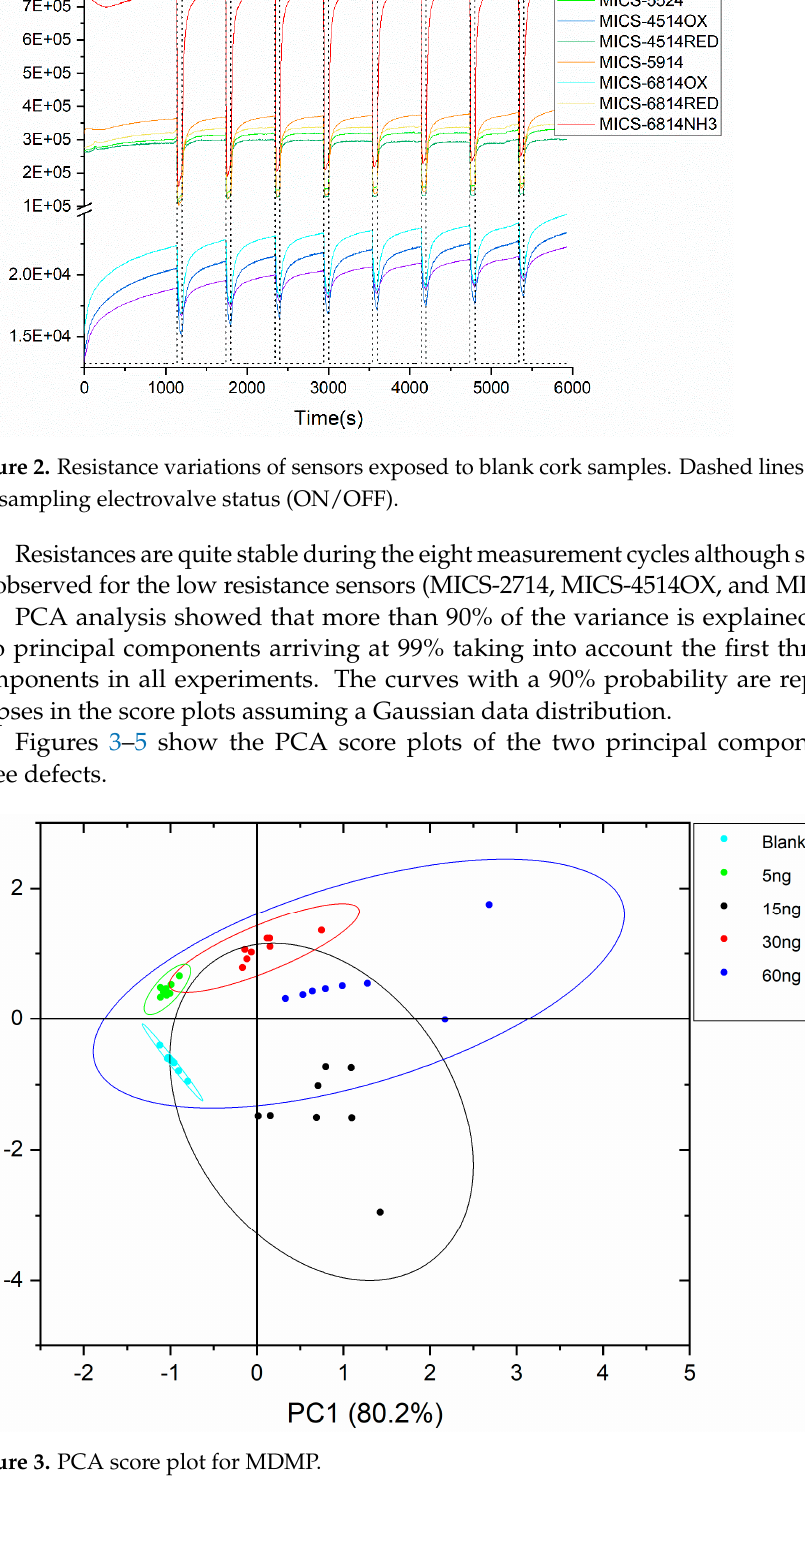
Figure 4. PCA score plot for TCA.